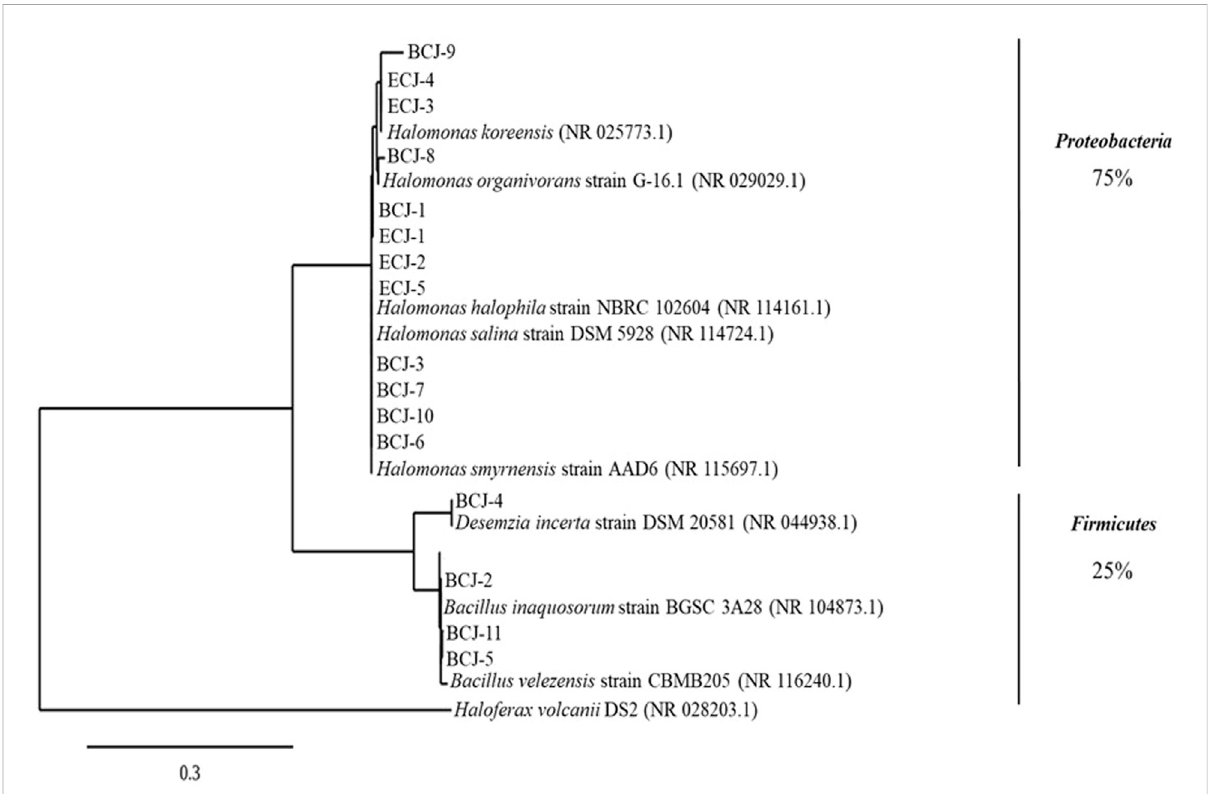
FIGURE 6 Phylogenetic tree of isolated species from bio fi lm and anolytes of nTBZ-CJ reactor by using culture depended approach. The taxonomy of the strains was determined via EzBioCloud. The phylogenetic dendrograms was constructed using the phylogeny. fr